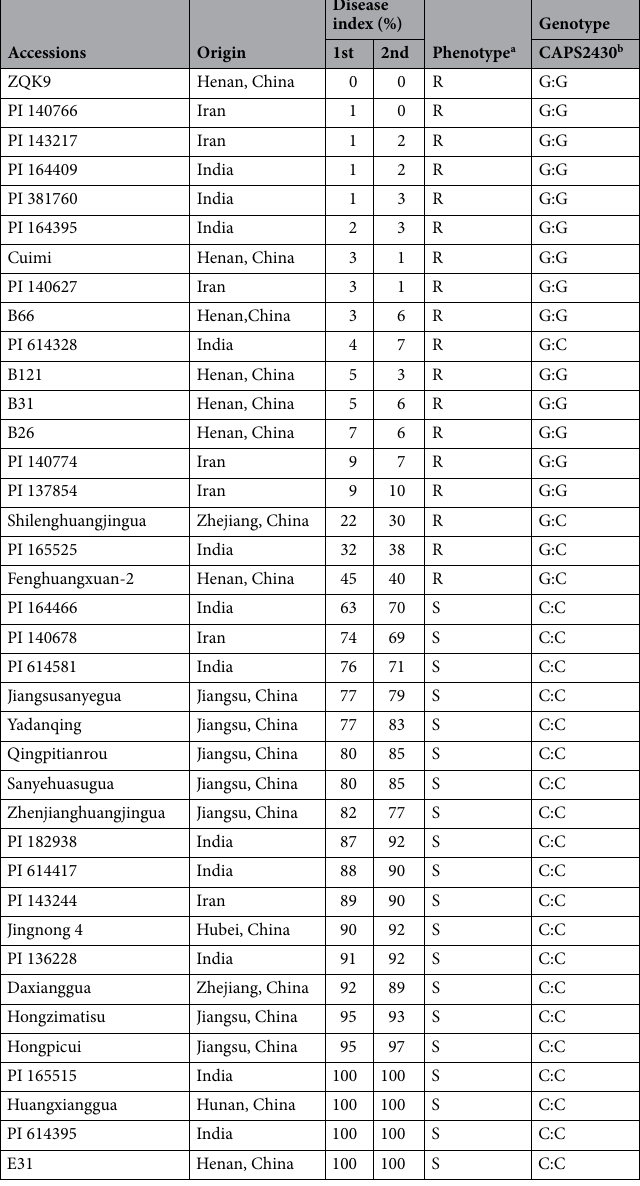
Table 4. Melon accessions used for marker efficiency analysis. 1st, the first resistance evaluation experiment. 2nd, the second resistance evaluation experiment. a Phenotype designation: (R) resistant phenotype, (S) susceptible phenotype. b Genotype designation of CAPS2430: (G:G) homozygous disease-resistant genotype, (G:C) heterozygous genotype, (C:C) homozygous susceptible